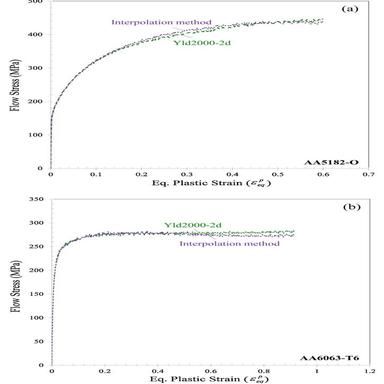
12. Comparison of the hardening response of (a) AA5182-O and (b) AA6063-T6 using an interpolation for shear anisotropy using Yld2000-2d and the phenomenological form of referred to as 'Interpolation method'.